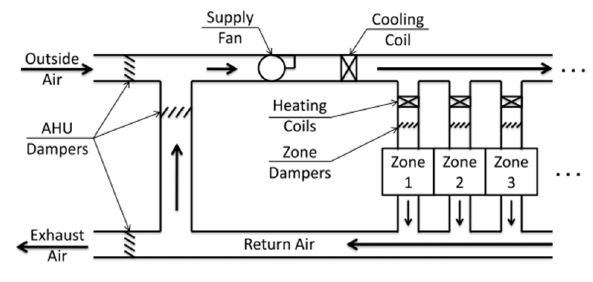
Figure 3. Scheme of a heating, ventilation and air conditioning (HVAC) system